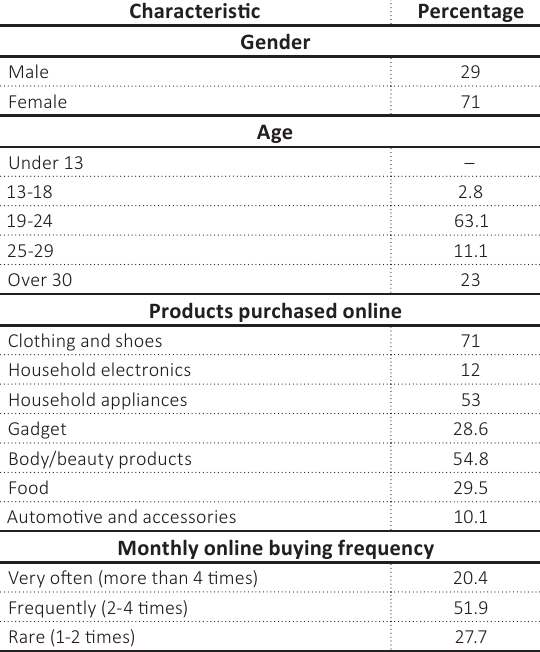
Table 1. Demographic profile and